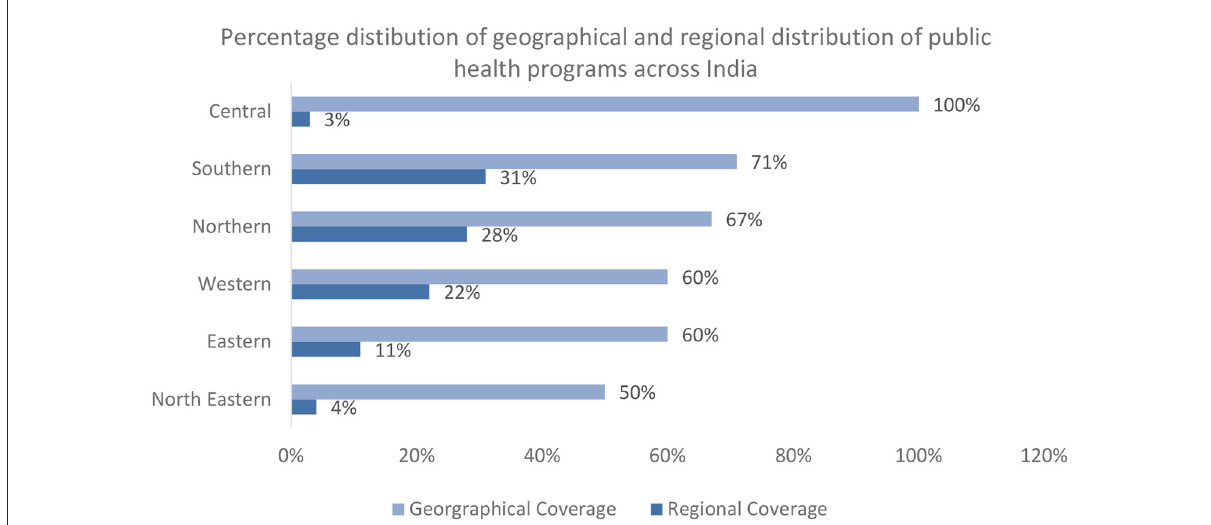
FIGURE2 Percentage distribution of all public health programs across different geographical areas and regions of India.